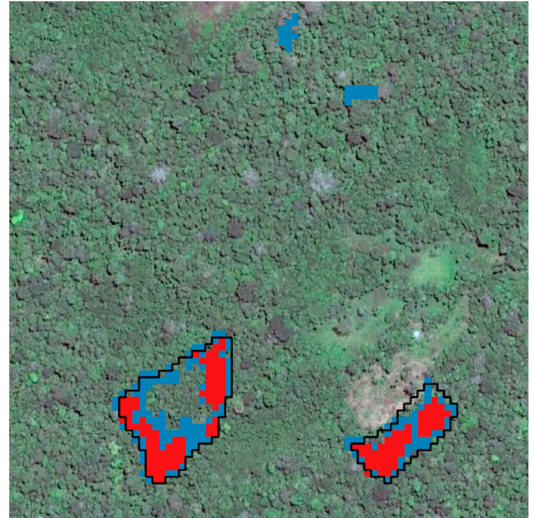
Figure 11. Detection and reconstruction of deforested patches in Peru in an 800 m × 800 m subset: detected shadows (red) and potentially deforested areas (blue). Isolated blue patches are rejected while blue patches connected with red patches are combined to form extended shadows, which are used to reconstruct the boundary of the deforested patch (in black). (Background optical image from Google